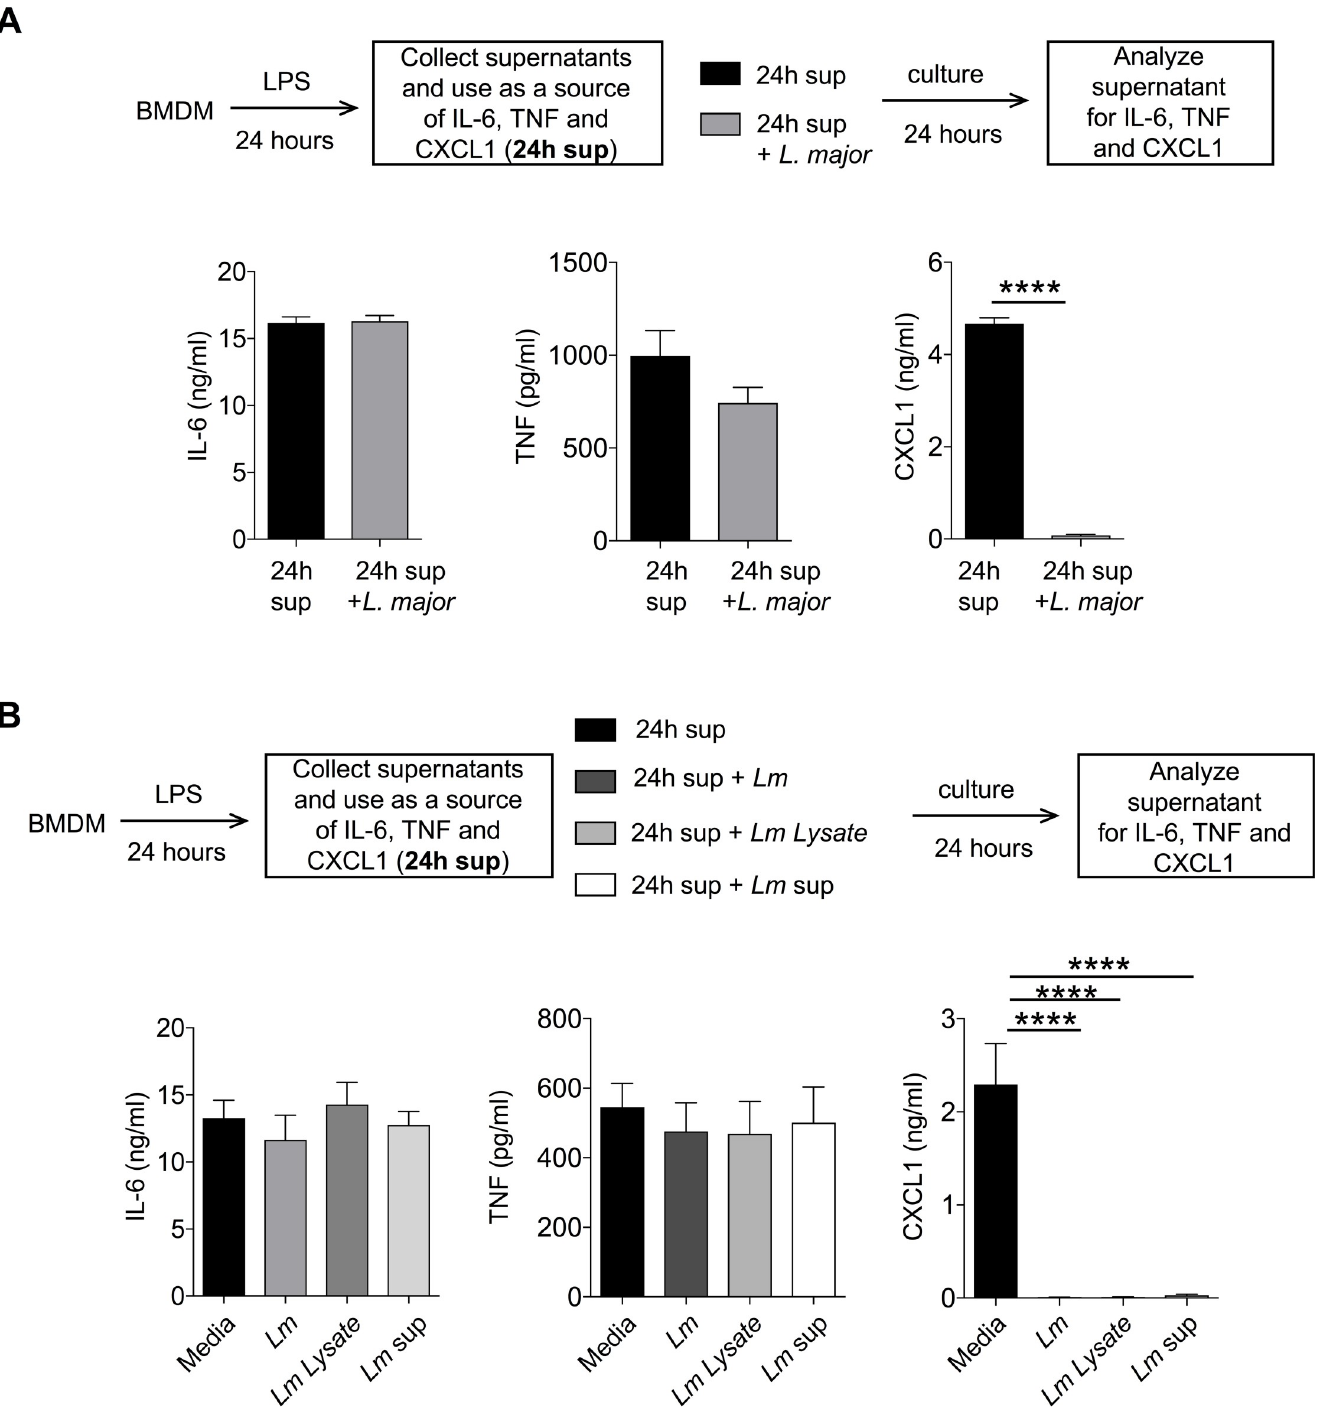
Fig 2. L . major inhibits CXCL1 detection in a cell free system. (A) Conditioned supernatants from 24h LPS (20 ng/ml)-stimulated BMDMs were treated with or without L . major for 24h and cytokines were analyzed by ELISA. (B) 24h LPS treated conditioned media from BMDMs were treated with or without L . major , L . major lysate ( Lm lysate), or L . major culture supernatant ( Lm sup) for 24h and cytokines were measured as in (A). Data are representative of at least three independent experiments. Results are represented as mean ± SEM. ���� P < 0.0001.